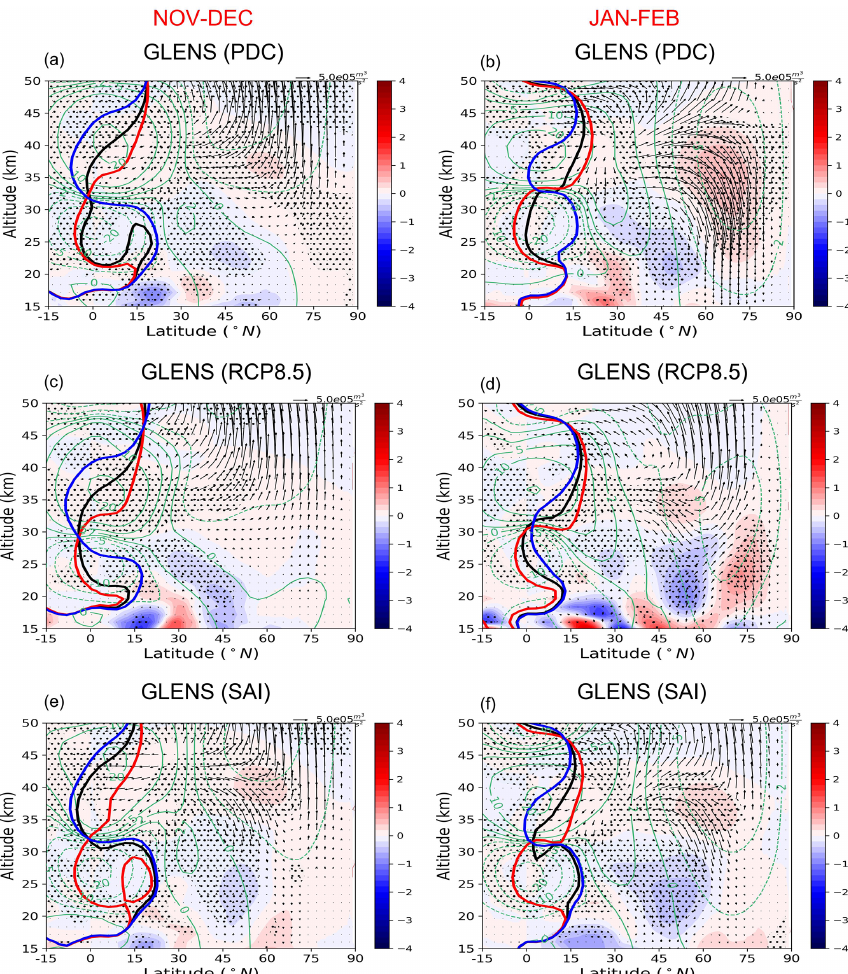
Figure 7. Latitude–height cross section of the QBOe–QBOw composite differences of the EP flux (arrows) and its divergence (color shaded in ms − 1 d − 1 ). The green contours are the zonal-mean zonal wind responses, and the solid red, blue, and black lines are the locations of the zero-wind line for the QBOw, QBOe, and climatology, respectively. The stippled areas indicate regions where the changes in the EP flux divergence are statistically significant at the 95% level according to the t